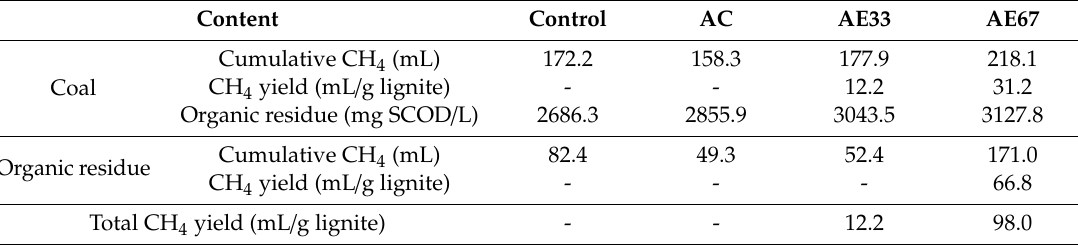
Figure 3. Excitation emission matrix for coal degradation intermediates: ( a ) control, ( b ) AC, ( c ) AE33, and ( d ) AE67. Table 2. Summary of the methane conversion of coal in an anaerobic batch reactor.